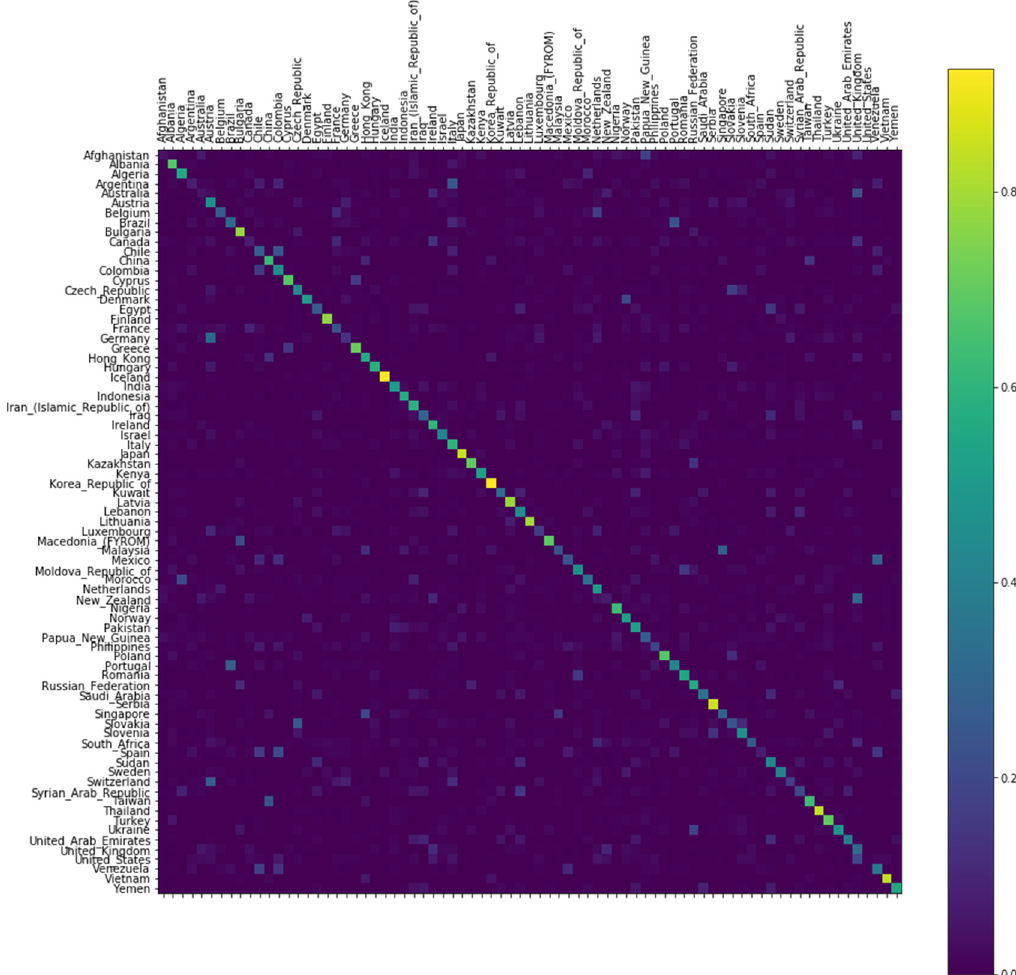
Figure 1. Confusion matrix of 77 nations; The brighter the color is, the higher is the predicted accuracy of the test dataset.